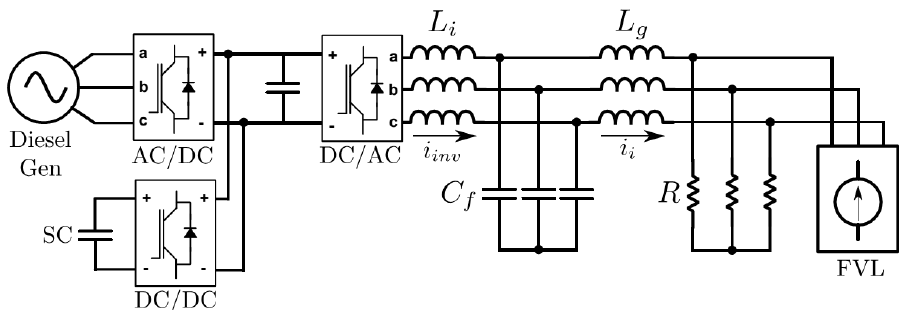
Figure 1. Structure of the studied microgrid.